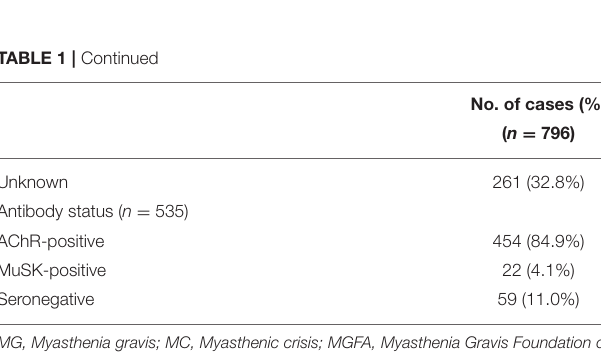
FIGURE 1 | Flow diagram of the study design. A total of 796 patients with MG were enrolled in the study, including 704 patients with MG without ADs and 92 with ADs (84 with 1 ADs and 8 with ≥ 2 ADs). MG, Myasthenia gravis; Ads, Autoimmune diseases.